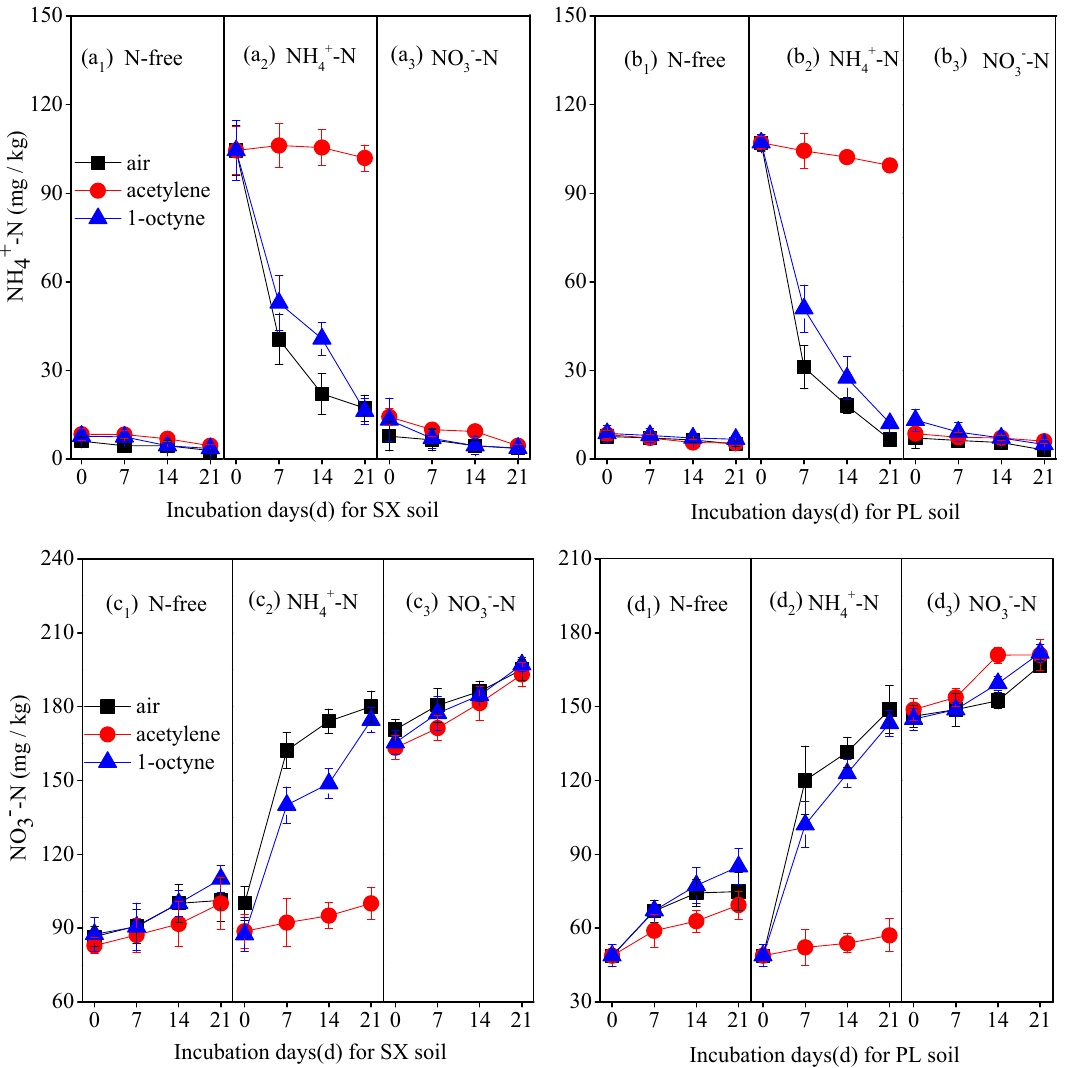
Figure 1. The dynamics NH 4 + -N content ( a 1 ~ a 3 , b 1 ~ b 3 ) and NO 3 − –N content ( c 1 ~ c 3 , d 1 ~ d 3 ) with different N fertilizers (N-free, ammonium-N, nitrate–N) in combination with air (no inhibitors), acetylene and 1-octyne during incubation of SX and PL soil, error bars represent standard errors of three biological